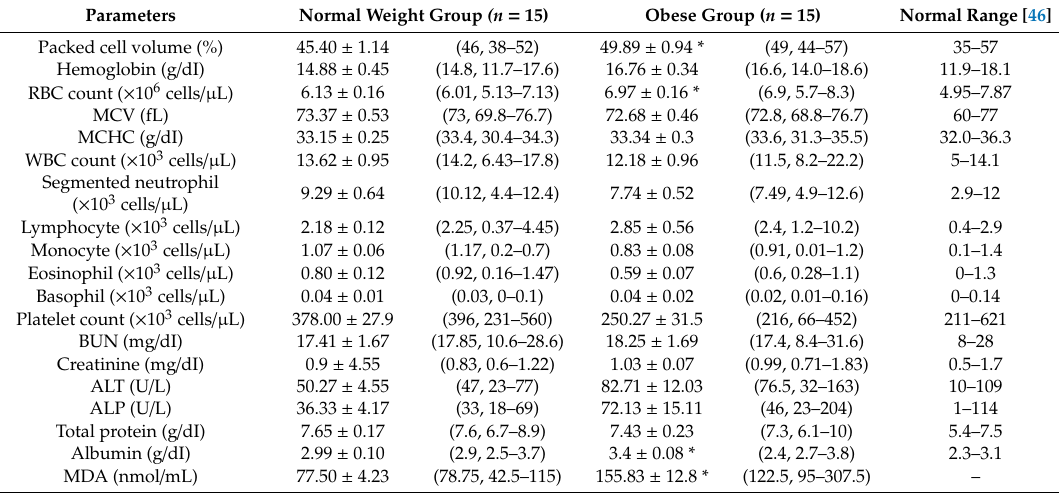
Table 2. Blood profile in normal weight and obese groups. Mean ± SE (median, minimum–maximum) are reported.